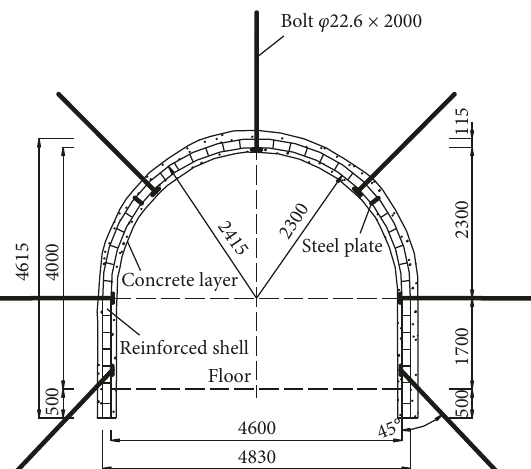
Figure 18: New support